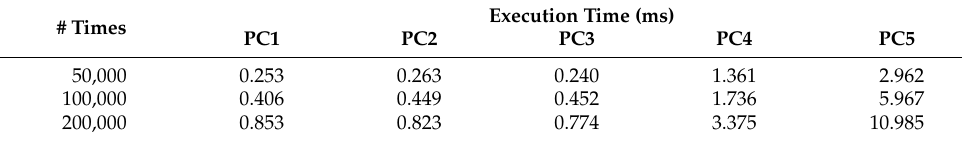
Table 13. Performance evaluation of bridge generic block.